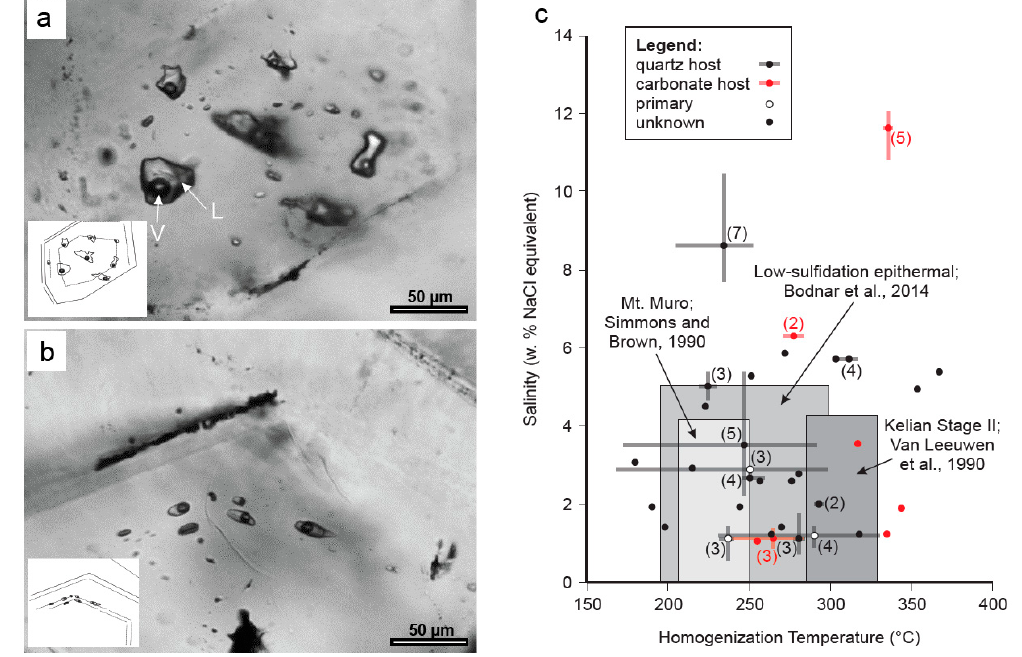
Figure 8. Fluid inclusion images in quartz. ( a , b ) Micrographs of primary FIAs in quartz. Note that the FIAs follow primary growth zones as illustrated in the inset images. ( c ) Plot of mean salinity vs. mean homogenization temperature by FIA. Field for low-sulfidation epithermal deposits modified from Bodnar et al. [29] is shown. Also, fields from the Mt. Muro and Kelian deposits in the KGB are shown from studies by Simmons & Brown [30] and Van Leeuwen et al. [17], respectively. Microthermometry on quartz-hosted aqueous fluid inclusion assemblages ( n = 13) and